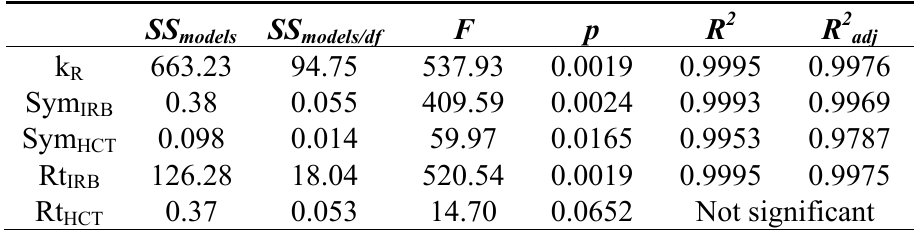
Table 6. Statistical parameters of models obtained by